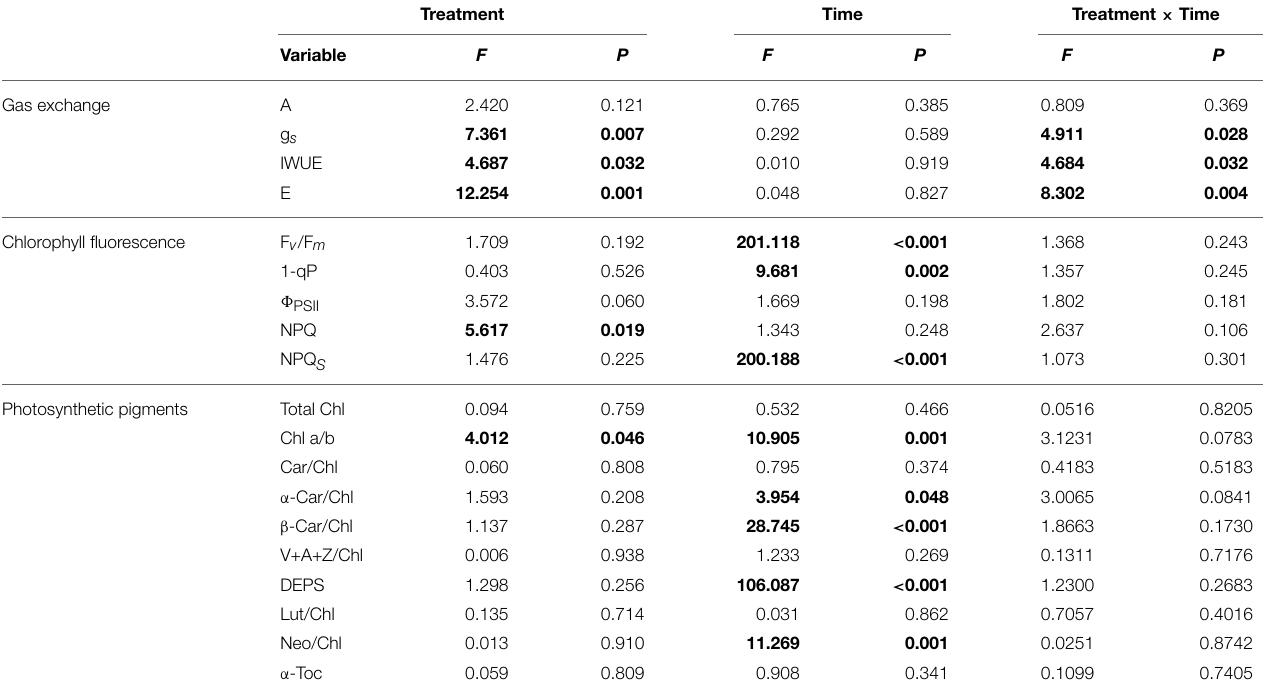
TABLE 3 | Summary of Two-Way ANCOVA analysis showing the effects of treatment and time (day of year) on gas exchange, chlorophyll fluorescence, and photosynthetic pigments.